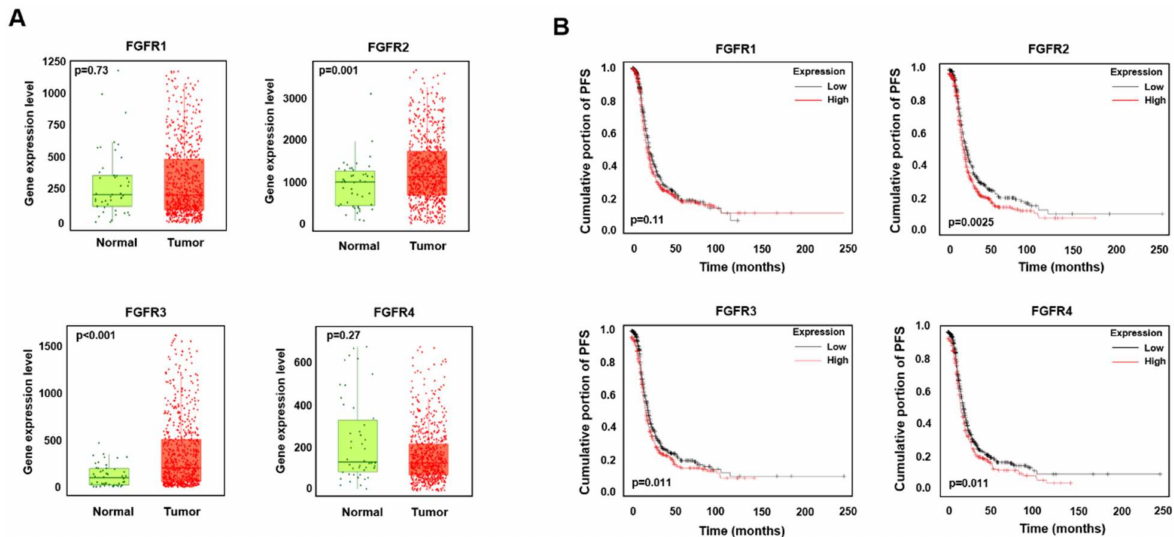
Figure 1. High expression of FGFR2 and FGFR3 is associated with low survival in ovarian cancer. ( A ) Box plot of gene expression between normal ovarian tissues and ovarian cancer tissues. Data were obtained from www.TNMplotter. com (accessed on 20 December 2020), which analyzed and visualized microarray data from NCBI Gene Expression Omnibus datasets. ( B ) Association between gene expression and progression-free survival. Data were obtained from www.KMplotter.com (accessed on 20 December 2020), which analyzed the data of patients with serous ovarian cancer from The Cancer Genome Atlas database. Affymetrix ID is valid: 207822_at (FGFR1), 203639_s_at (FGFR2), 204380_s_at (FGFR3), and 204579_at